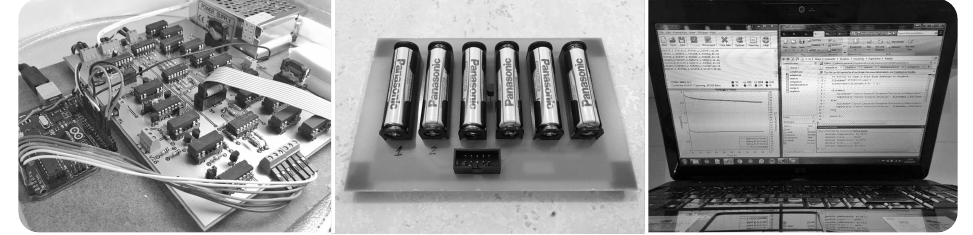
Figure 4. Test-bed used for the experimental